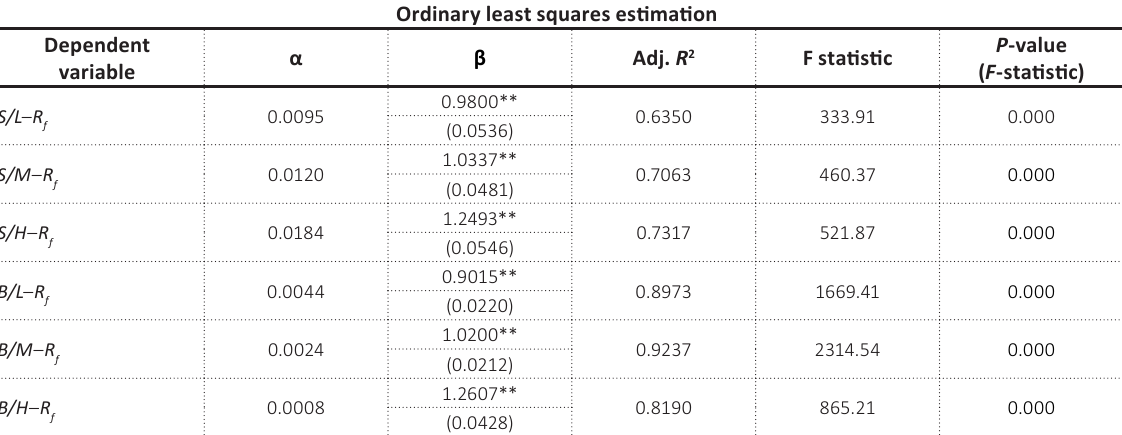
Table 1. Test results for the capital asset pricing model in the Indian stock market Source: Calculated by the authors based on the data available on Prowess IQ database.